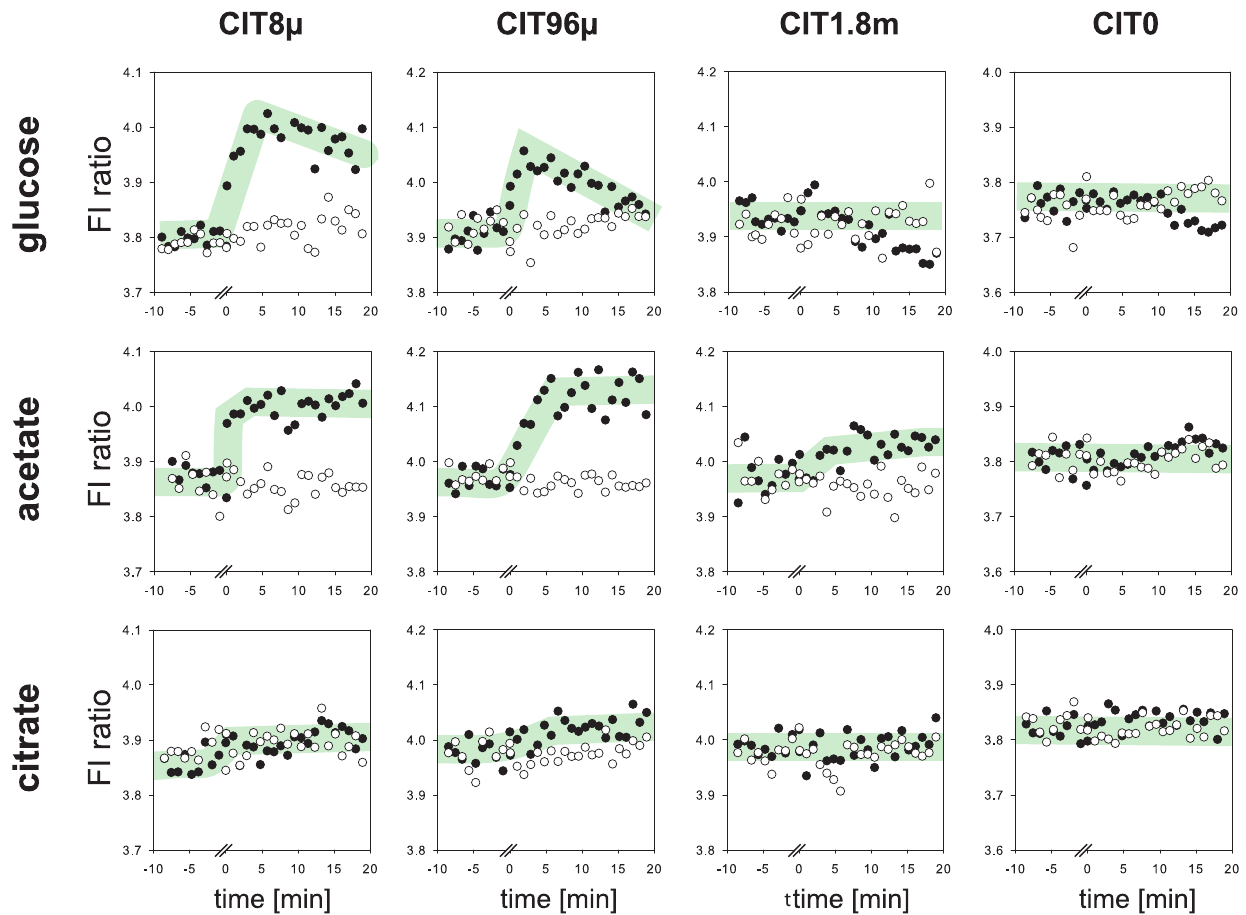
Figure 3. Response of citrate concentration in E.coli upon addition of different carbon substrates after starvation. The response was monitored by citrate nanosensors of different affinities. Time zero indicates the addition of glucose, acetate or citrate; this interrupted the measurement for approximately 20 s. White dots represent the buffer controls. FI: fluorescence intensity.